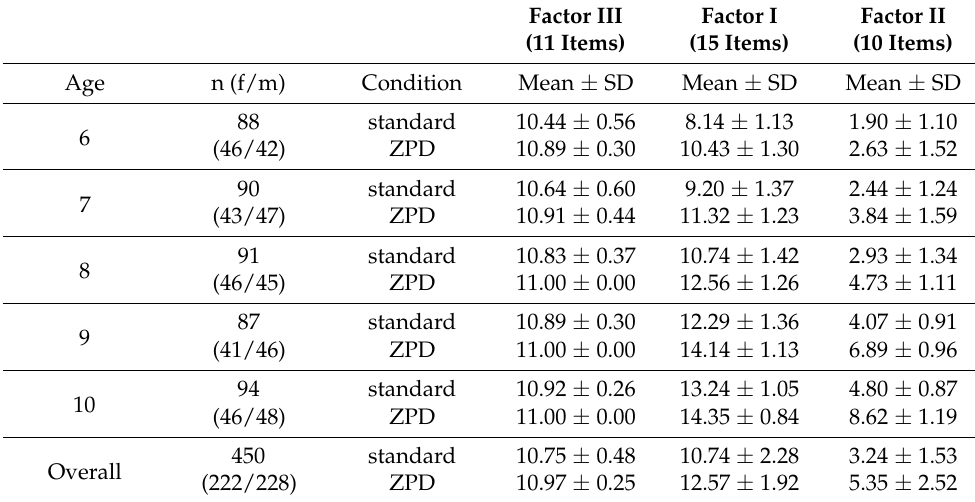
Table 1. Mean values of the RCPMs in the three factors in the standard and in the ZPD conditions.